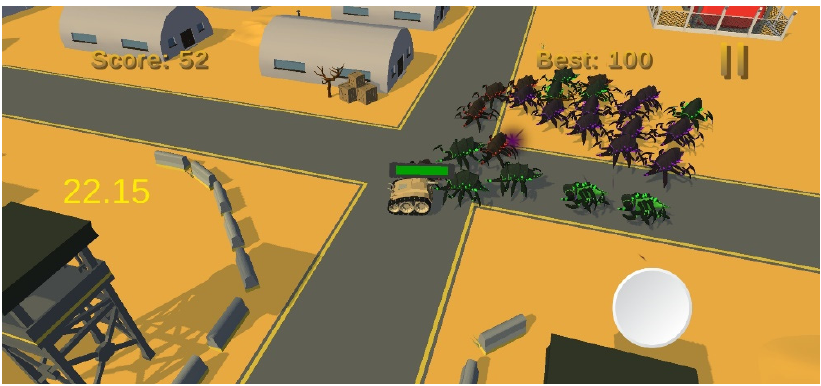
Figure 19. Snapshot after the elimination of 52 enemies in the non-optimized version of the game.